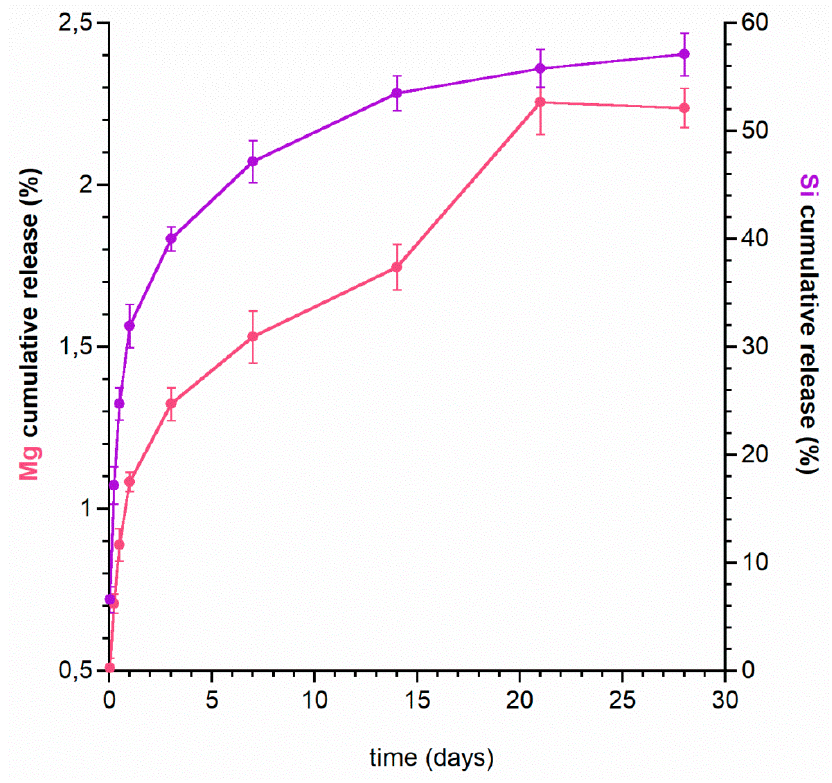
Figure 3. Magnesium and silicon release profiles from Mg,Si-HA powder.